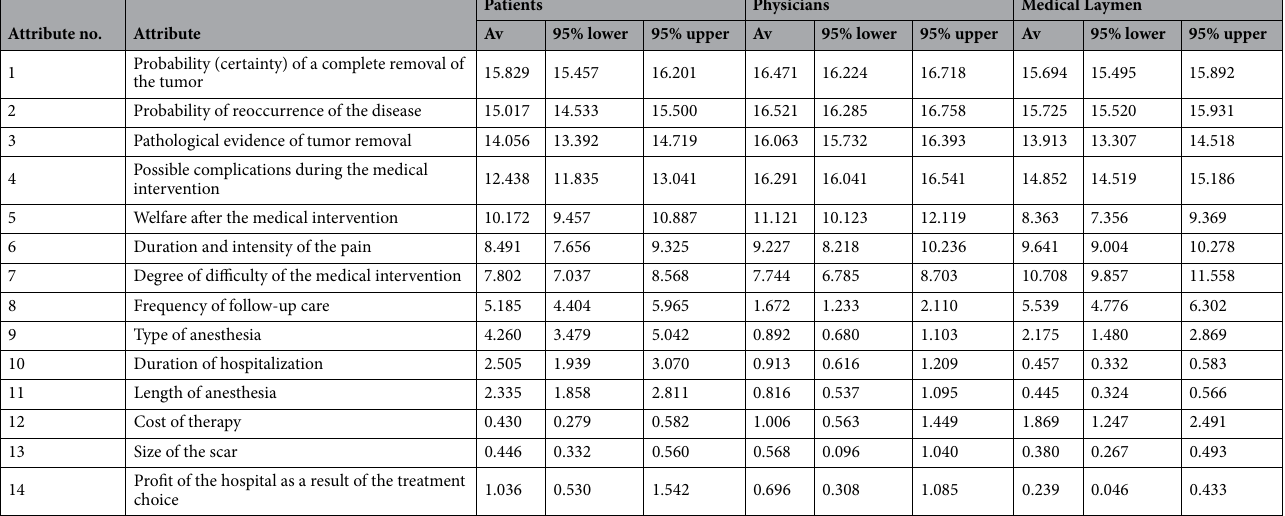
Table 5. Part-worth utility of each clinical attribute – hierarchical Bayes analyses.